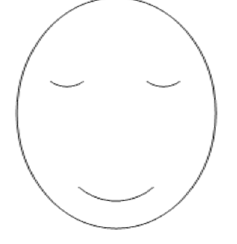
Figure 1. A face model.